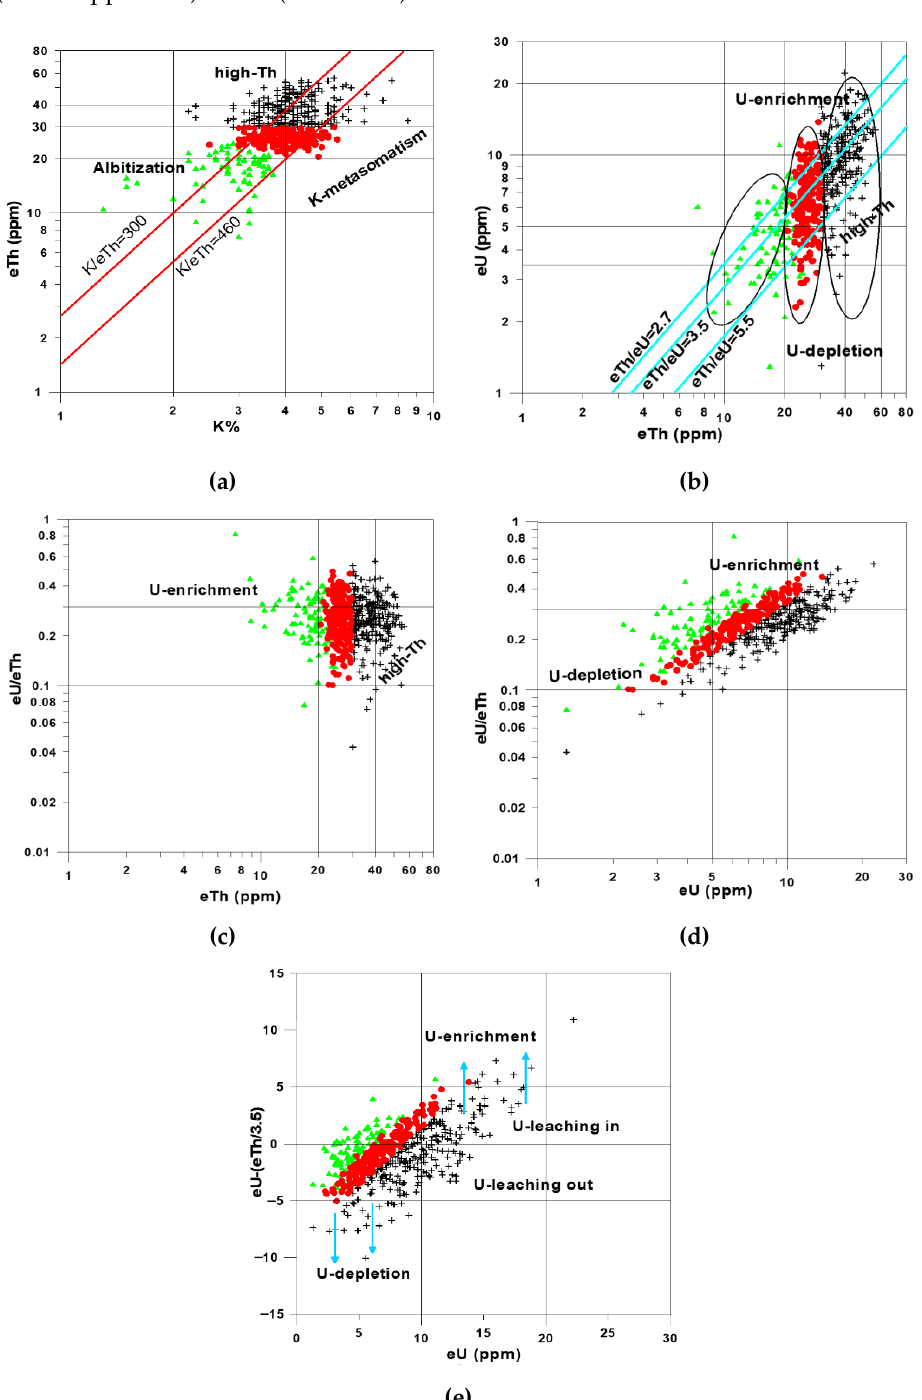
Figure 2. Radioactive element plots for ground gamma ray spectrometry measurements of syenogranite, alkali feldspar granite and quartz syenite at Nikeiba, Southeastern Desert, Egypt. Symbols are the same in the following diagrams ( + syenogranite, alkali feldspar granite and quartz syenite); diagram axes indicate data plots in logarithmic scale. ( a ) eTh (ppm) vs. K %; ( b ) eU (ppm) vs. eTh (ppm); ( c ) eU/eTh ratio vs. eTh (ppm); ( d ) eU/eTh ratio vs. eU (ppm); ( e ) eU-(eTh/3.5) vs. eU (ppm) binary diagrams.